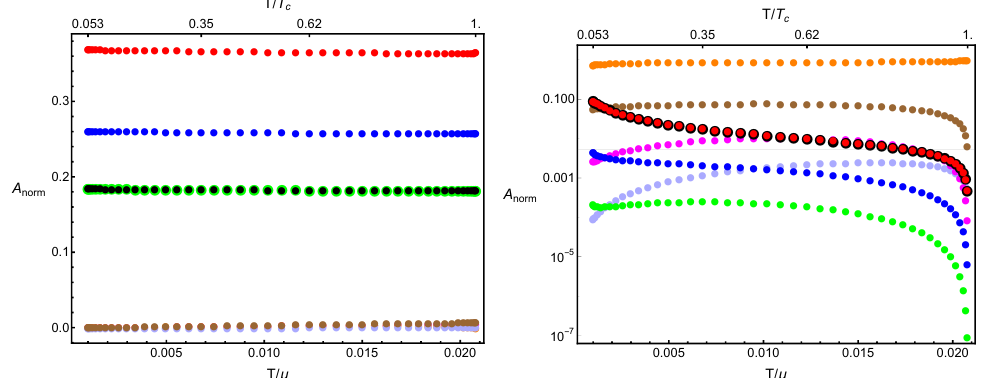
Figure 12 . The amplitudes of the fluctuations (4.7) for first ( left ) and second sound ( right ) at fixed ω/T = 0 . 01 in the superfluid phase ( T < T